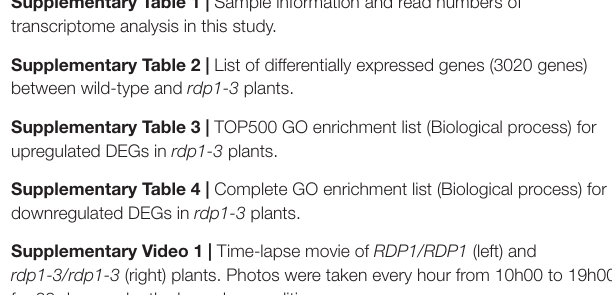
Supplementary Figure 3 | Pollen number from four genotypes of quantitative complementation test between Bor-4 and Col-0 accession. Sample numbers are shown above the plots. Boxplots show center line: median; box limits: upper and lower quartiles; whiskers: not greater than 1.5 times the interquartile range; point: outlier. Violin shape corresponds to the density of data. Supplementary Table 1 | Sample information and read numbers of transcriptome analysis in this